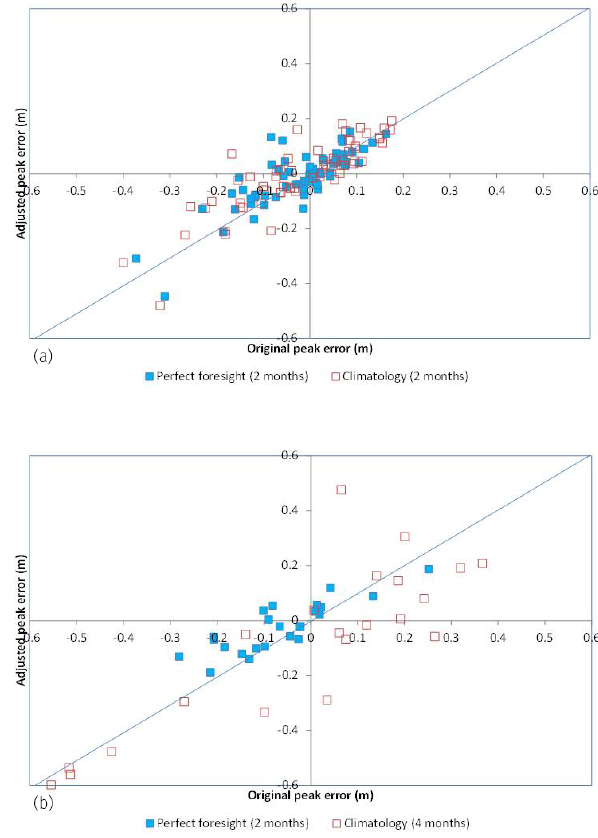
Figure 7. Illustration of the effect of an ARMA approach for the full records using (6.5) models with climatological inputs and (3.2) models with perfect foresight for (a) Lake Victoria and (b) Lake Malawi with a one-to-one trend line as a